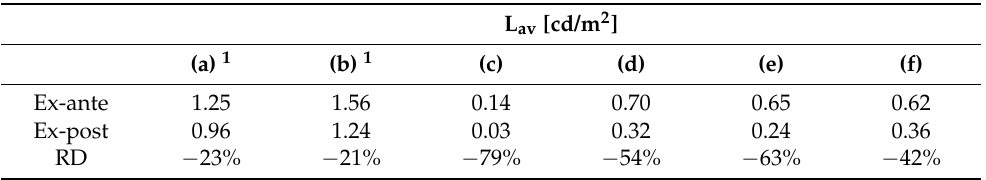
Table 15. Observation point E1: (a) Bell tower, (b) Belvedere tower, (c) residential building, (d) residential building, (e) residential building, (f) Historic wall. Table 20. Observation point I1. Luminance contrasts.